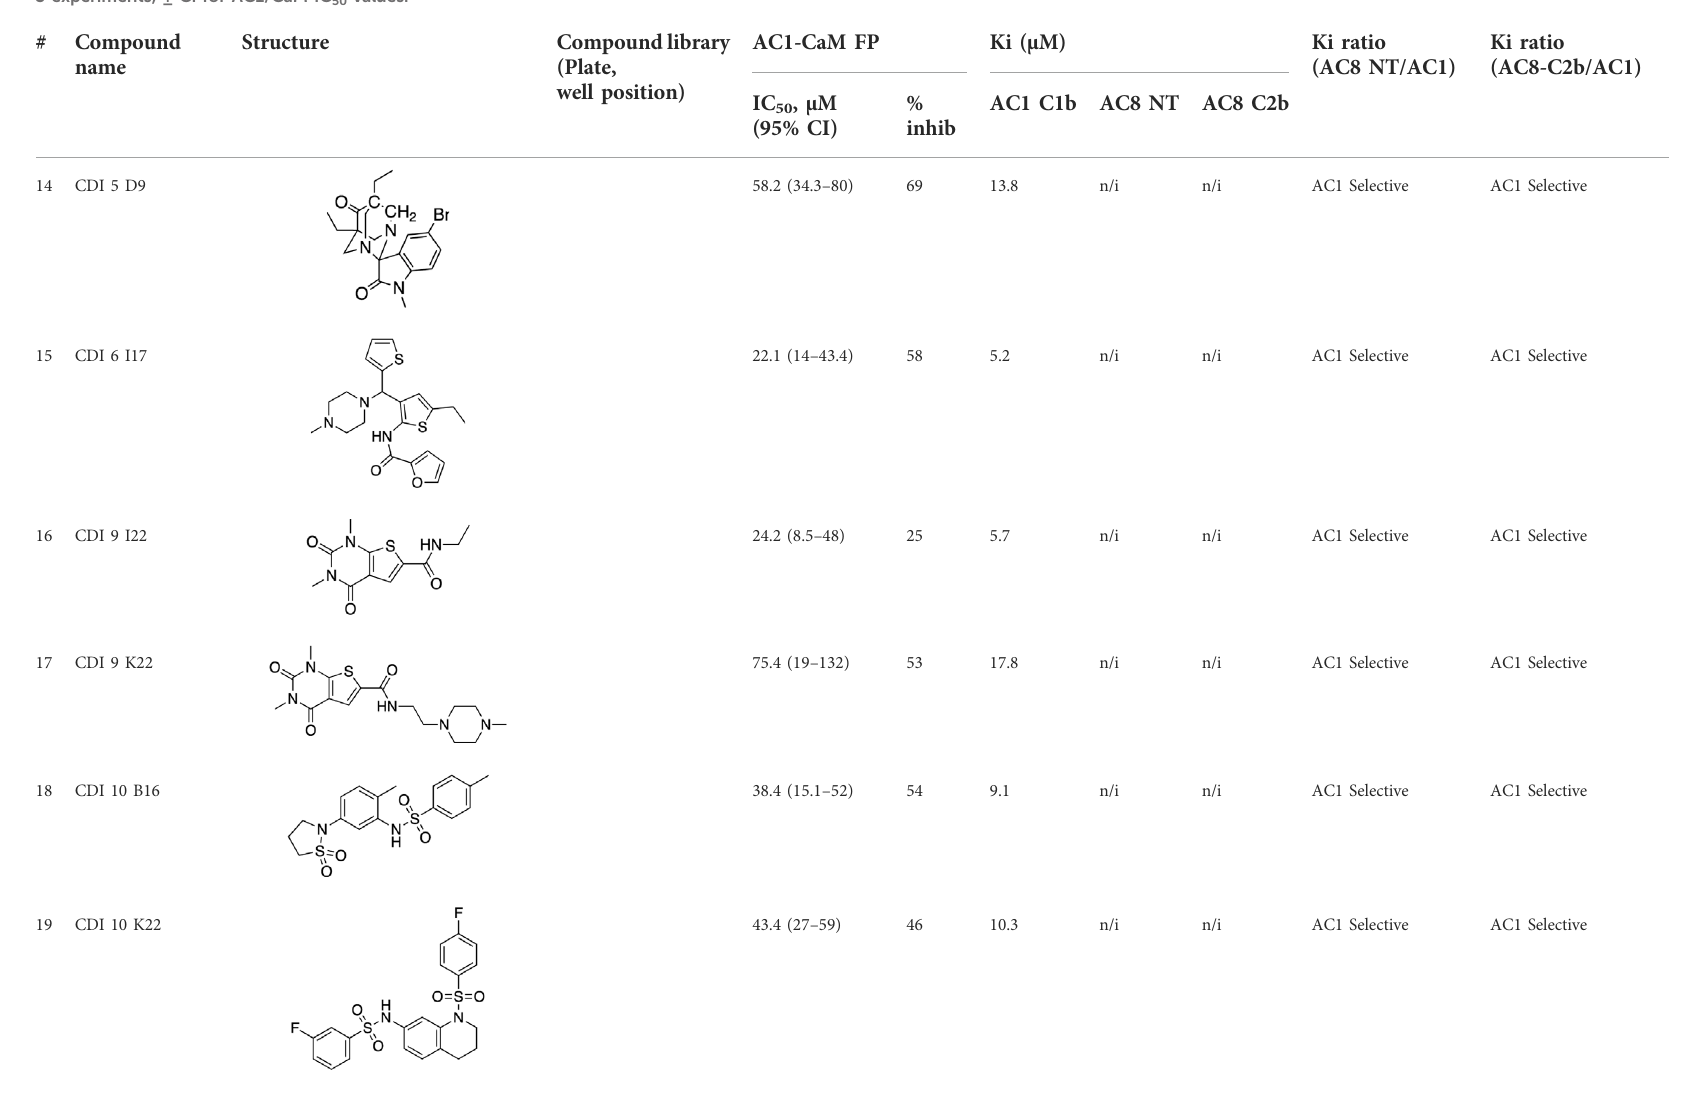
TABLE 3 ( Continued ) AC1/CaM pilot screen CRC analysis. IC 50 and % inhibition relative to 100 μ M CDZ (100% inhibition) obtained for each compound in the AC1/CaM FP assay. The Ki values obtained with experimentally determined K D values for each AC/CaM FP assay and the IC 50 values obtained for each compound in the designated AC/CaM FP assay. The fi nal two columns show the K i ratios obtained for either AC8-Nt/CaM or AC8-C2b/CaM over AC1/CaM. Values with K i ratios greater than 1 were more potent in the AC1/CaM FP assay over the designated AC8/CaM FP assay. All data represents n = 3 experiments, ± CI for AC1/CaM IC 50